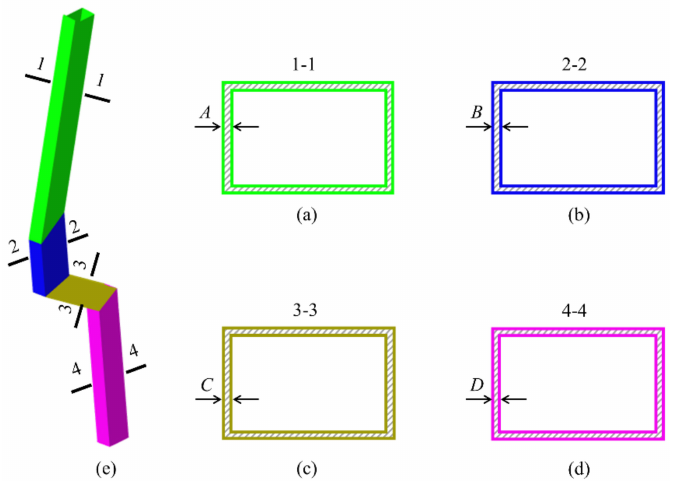
Figure 12. Parameters of thickness for VSCP: ( a ) thickness of Part I and parameter A; ( b ) thickness of Part II and parameter B; ( c ) thickness of Part III and parameter C; ( d ) thickness of Part IV and parameter D; ( e ) VSCP